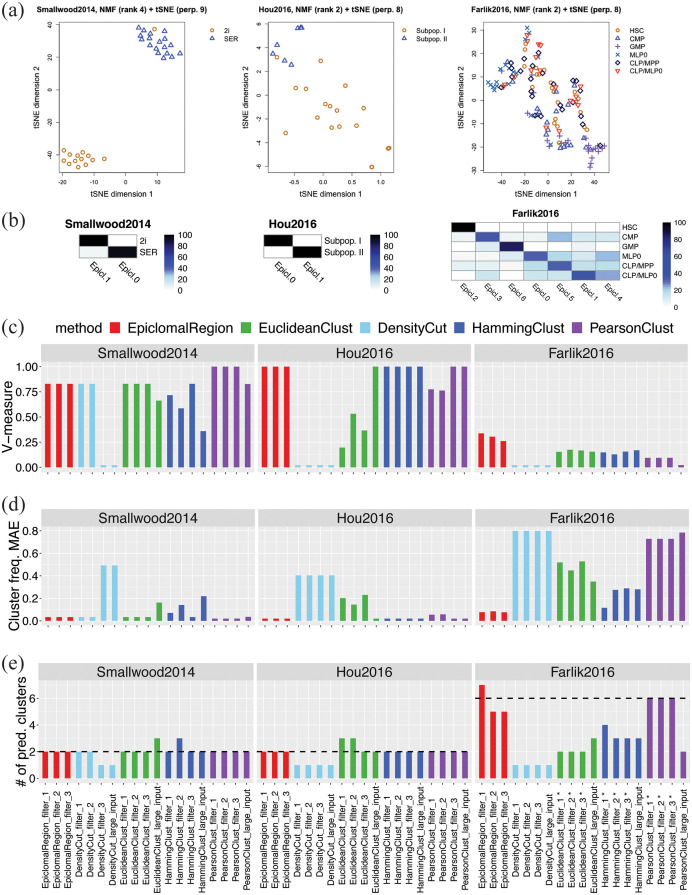
Results on the real data sets.(a) Dimensionality reduction visualization plots showing the clustering reported in the published papers on the ≈ 10,000 loci processed data sets. (b) Co-clustering between the real data published clusters on the rows and EpiclomalRegion predictions on the columns. Each entry aij is the percentage of cells in published class i that are present in predicted cluster j, with the rows summing up to 100%. A perfect agreement would result in a square matrix with a black diagonal. (c) V-measures comparing the cell assignments with the published assignments, with higher values meaning better agreement. (d) Cluster frequencies mean absolute error, comparing the inferred proportions of clusters with the published proportions, with lower values meaning better agreement. (e) Number of predicted clusters. The horizontal dashed lines correspond to the published number of clusters; bars closer to this line represent better agreement.